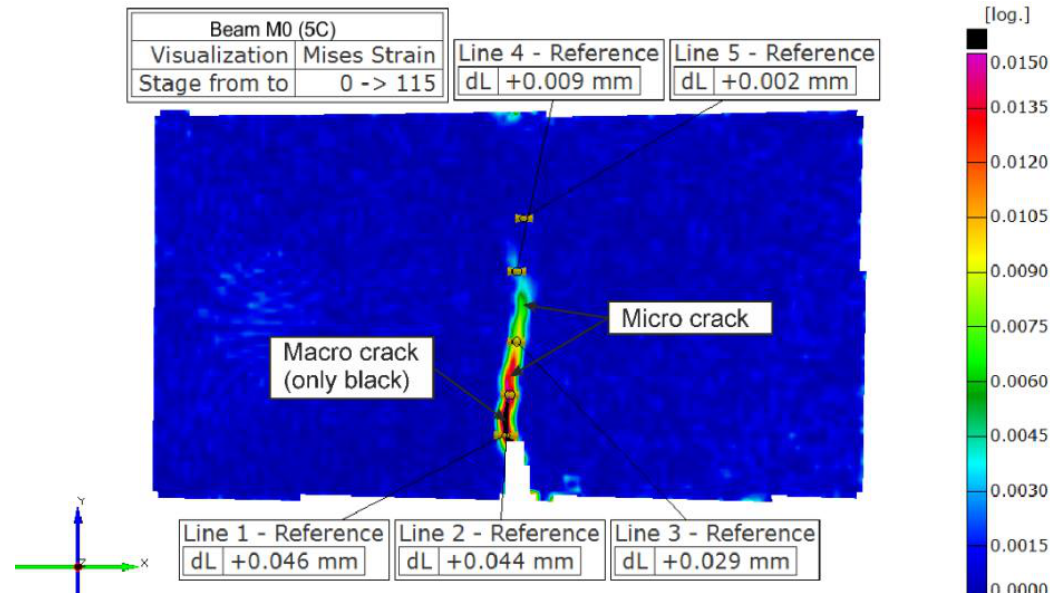
Figure 3. Interpretation of what we consider a macro-crack—on the example of material M0.